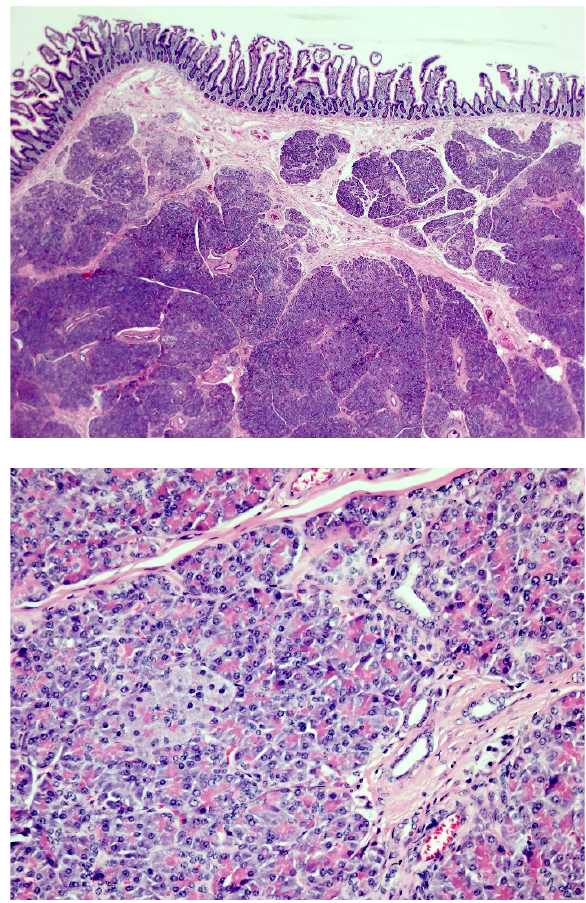
Figure 4. ( Upper ) hematoxylin and eosin stain, 50×; ( lower ) 100×.